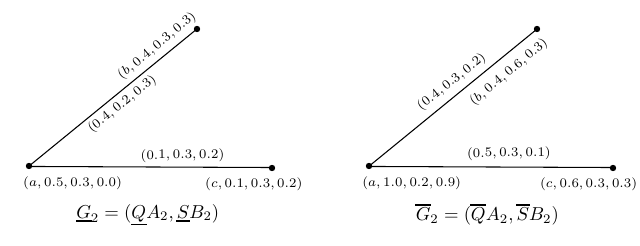
Figure 7. Neutrosophic soft rough graph G 2 “ p G 2 , G 2 q